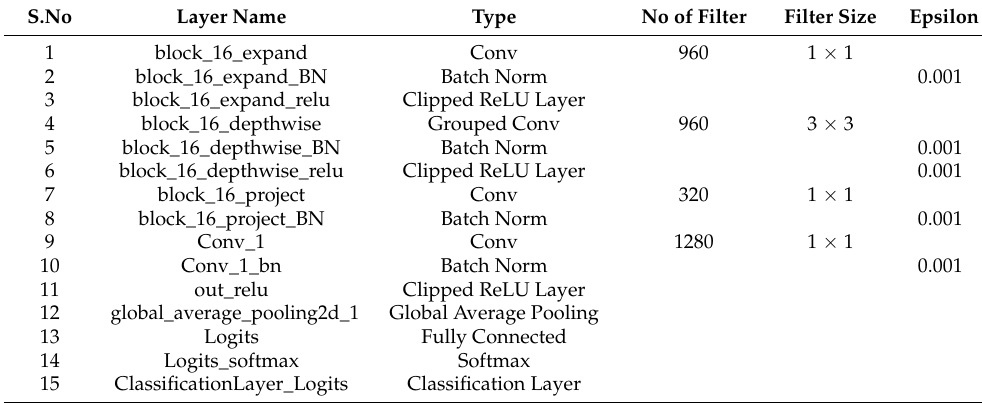
Table 2. Characteristics of added layers in the proposed hybrid